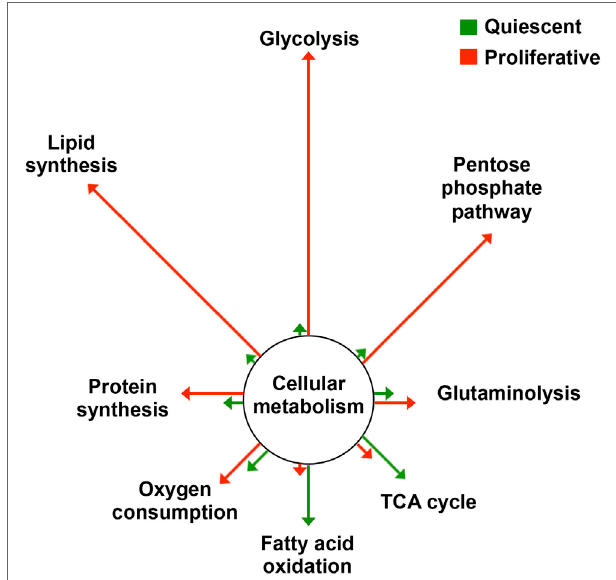
FiGURe 1 | Metabolic reprogramming in proliferation. The changes in flux through the main pathways of cellular metabolism are depicted in proliferative cells (red) relative to that of quiescent cells (green). Arrows’ length is proportional to the relative change in flux. Data adapted from Ref. (2–5). Abbreviation: TCA cycle, tricarboxylic acid